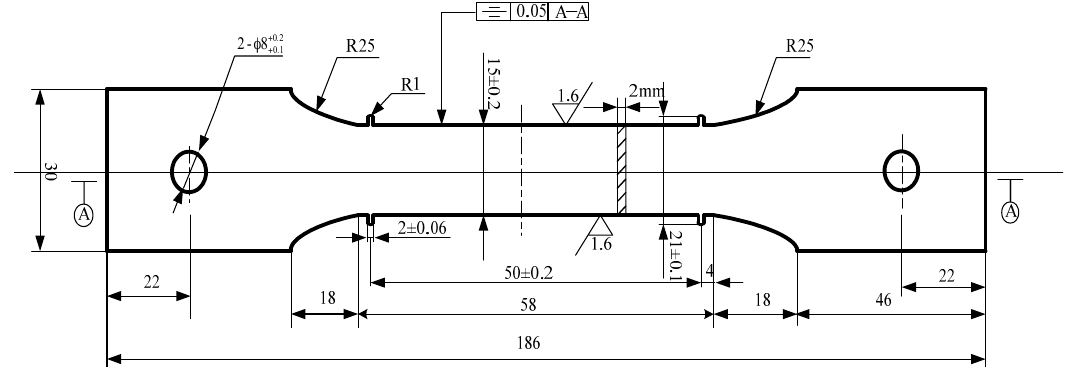
Figure 1. The size of the samples (unit: mm).